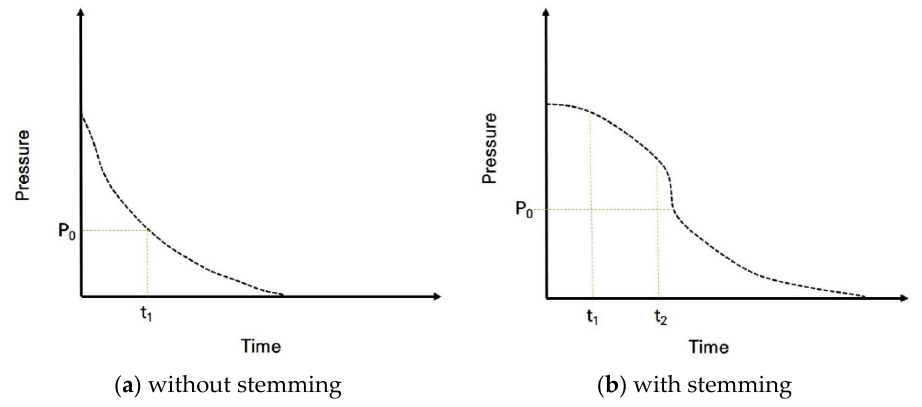
Figure 16. Concept curves of pressure and time: ( a ) without stemming, and ( b ) with stemming.